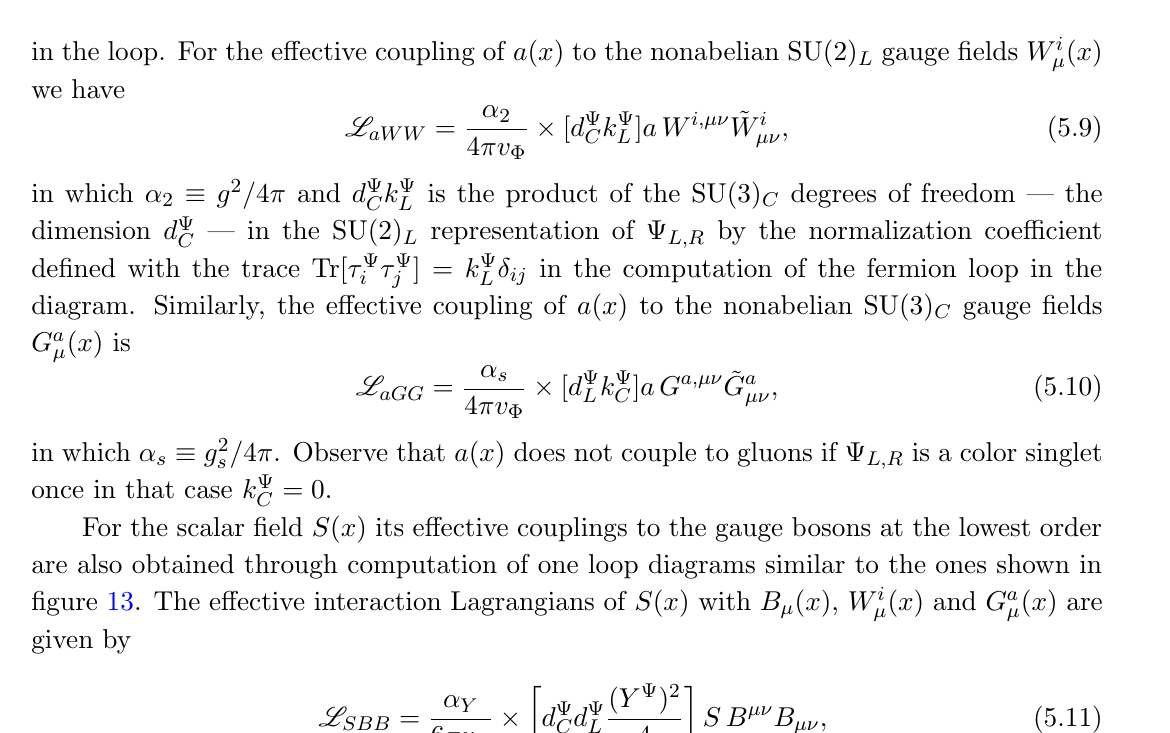
Figure 13 . Triangle diagrams contributing to the e(cid:11)ective axion-like (cid:12)eld to the vector bosons, a(cid:13)(cid:13) , aGG , aW + W (cid:0)